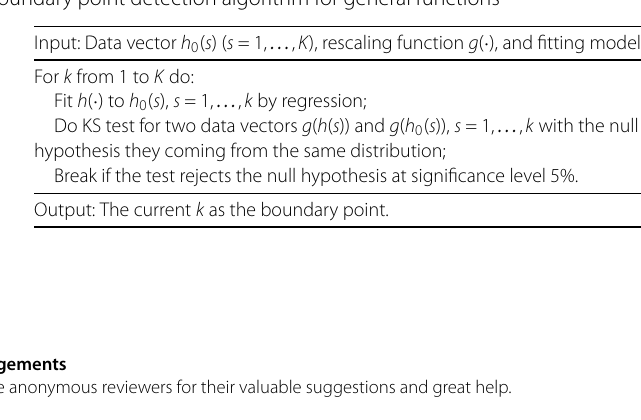
Table 7 Boundary point detection algorithm for general